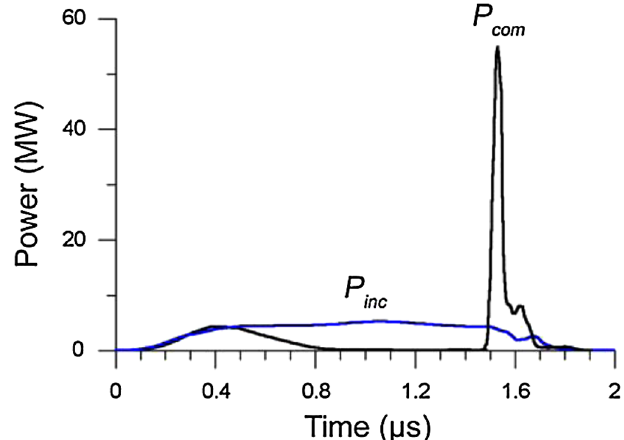
FIG. 8. (Color) Oscilloscope traces of the incident P pulses. The gas pressure was 0.4 Torr, the compressed P com power of the incident pulse 5.1 MW, the peak power of the compressed pulse 53 MW, the pulse duration 43 ns FWHM, and the total compression